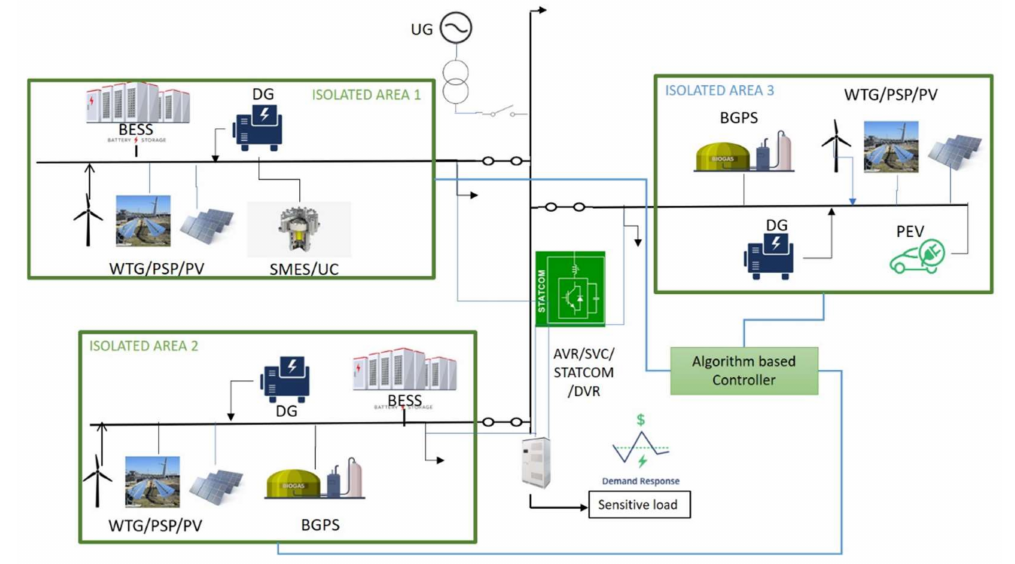
Figure 3. Representational diagram of the